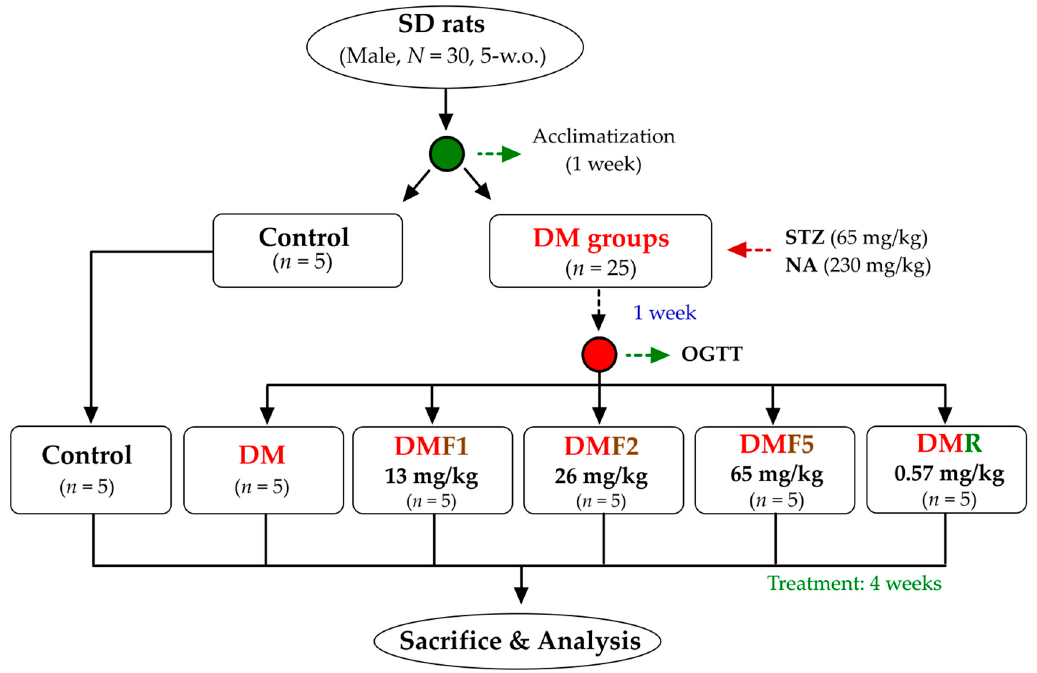
Figure 9. The flowchart of fucoxanthin treatment against streptozotocin-nicotinamide (STZ-NA)- induced diabetes Sprague-Dawley (SD) rat model. DM, diabetes; DMF, diabetes treated with fucoxanthin; DMR, diabetes treated with rosiglitazone.